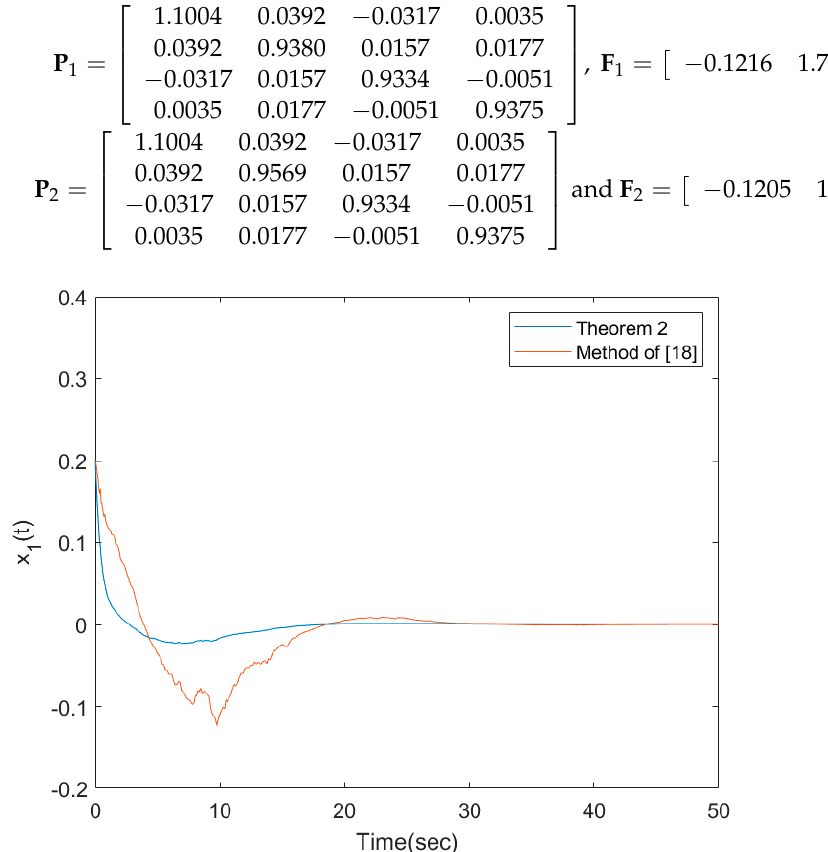
Figure 1. Comparison between this paper’s method and [18].